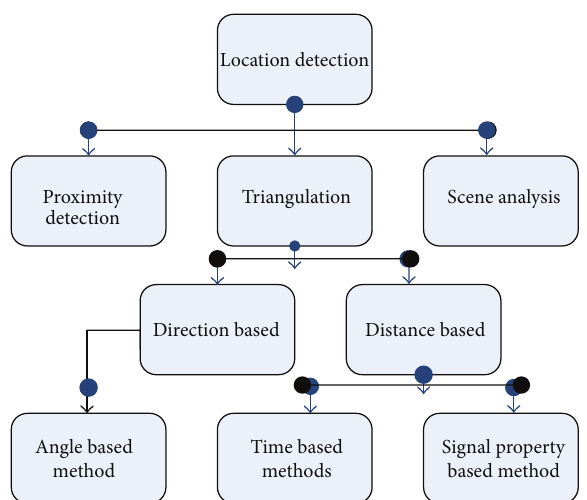
Figure 3: Location detection based classification.